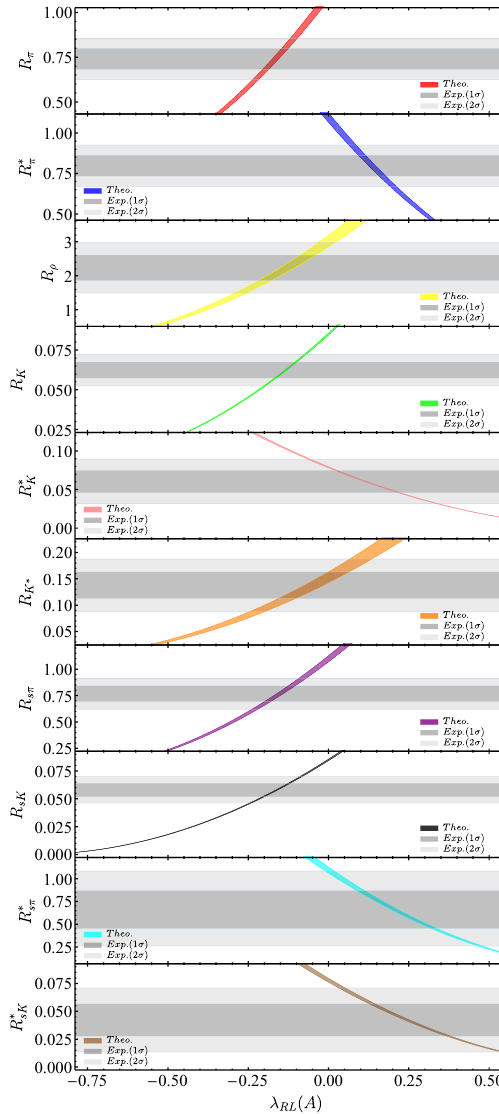
Figure 16 . Constraints on the effective coefficients λ RR ( A ) (left) and λ RL ( A ) (right) from the ratios R ( ∗ ) collected in table 6. The other captions are the same as in figure ( s ) L